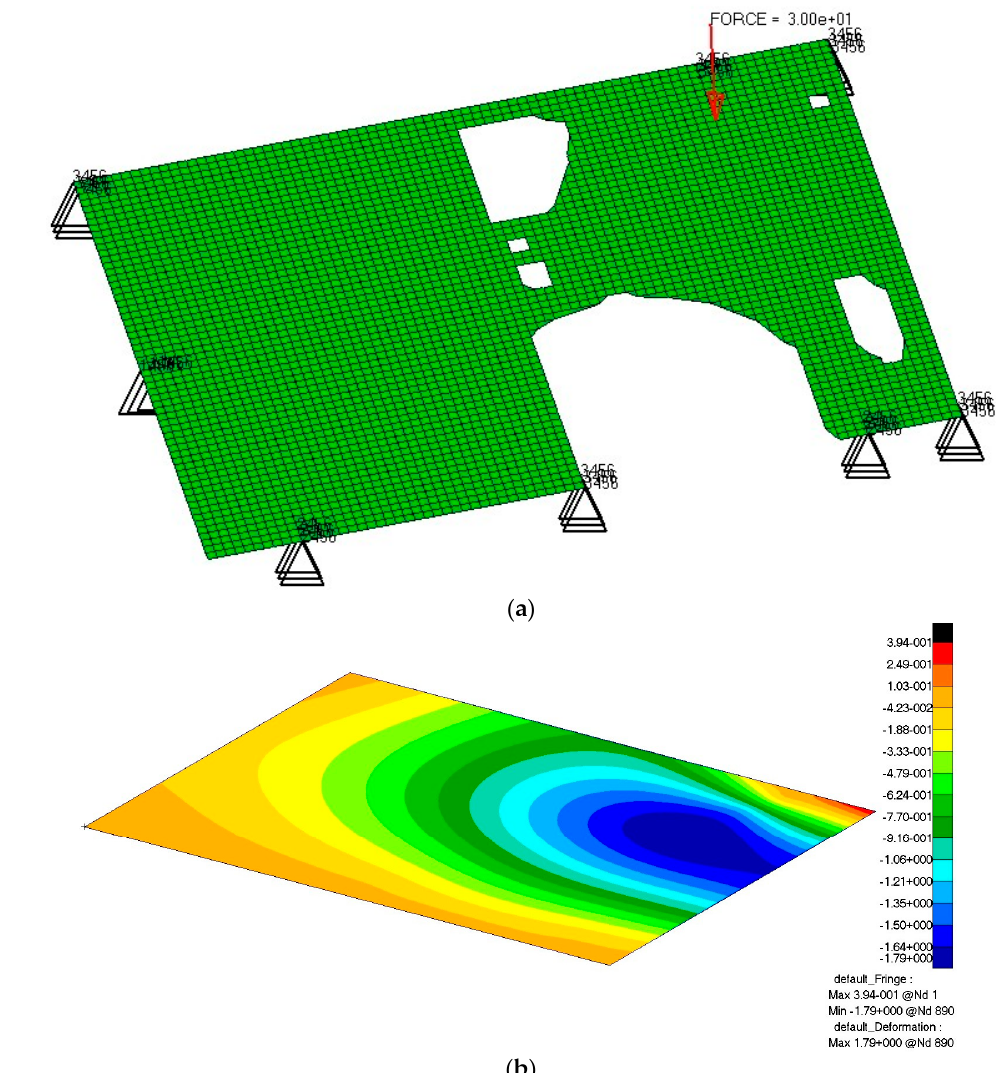
Figure 8. ( a ) Subcase 2: population reduction after topology optimization, ( b ) Subcase 2: optimum layout maximum deformation.